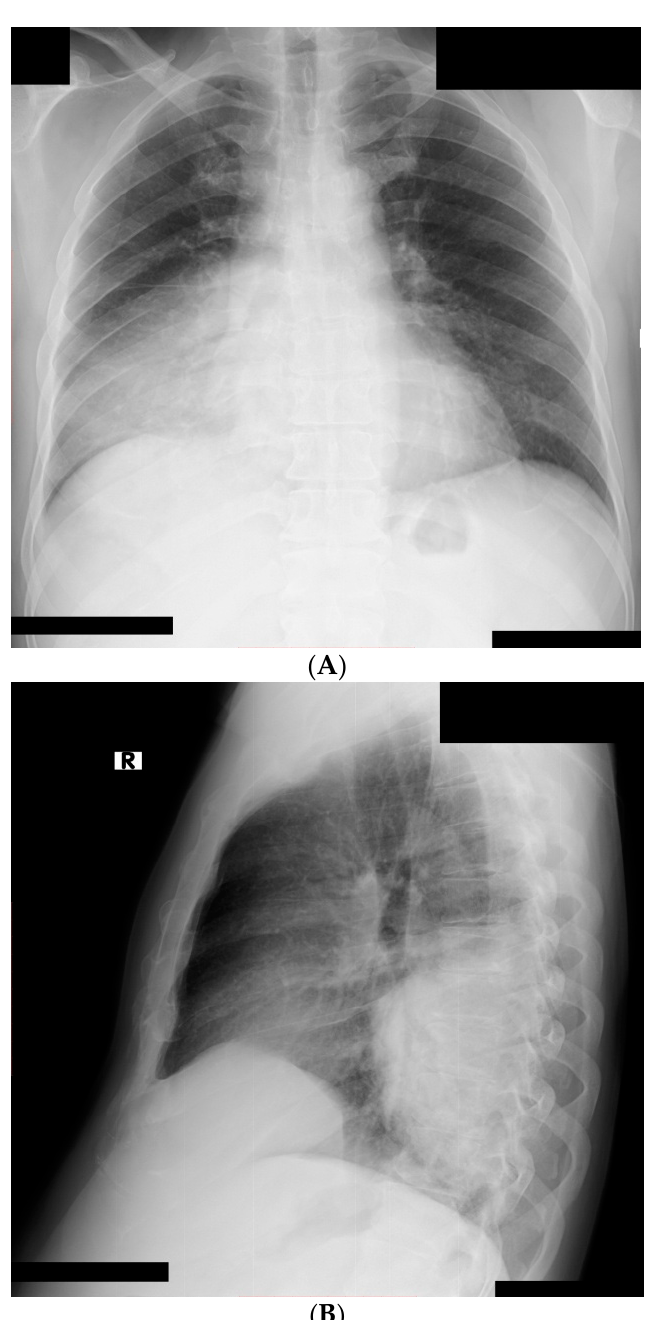
Figure 1. Chest X-ray: right pulmonary condensation syndrome (( A ) postero-anterior view; ( B ) latero-lateral view) .